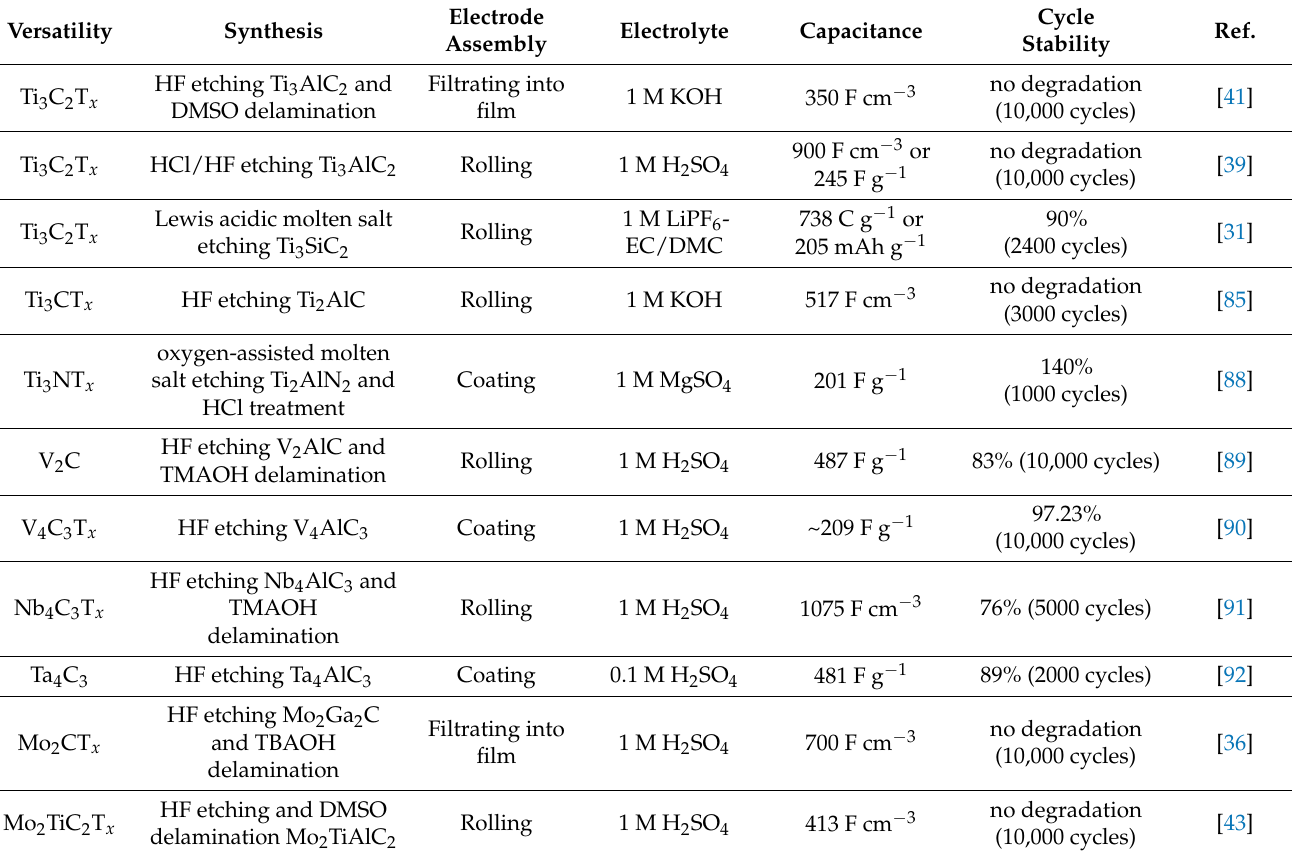
Table 1. Capacitive capabilities of different MXene electrode materials for